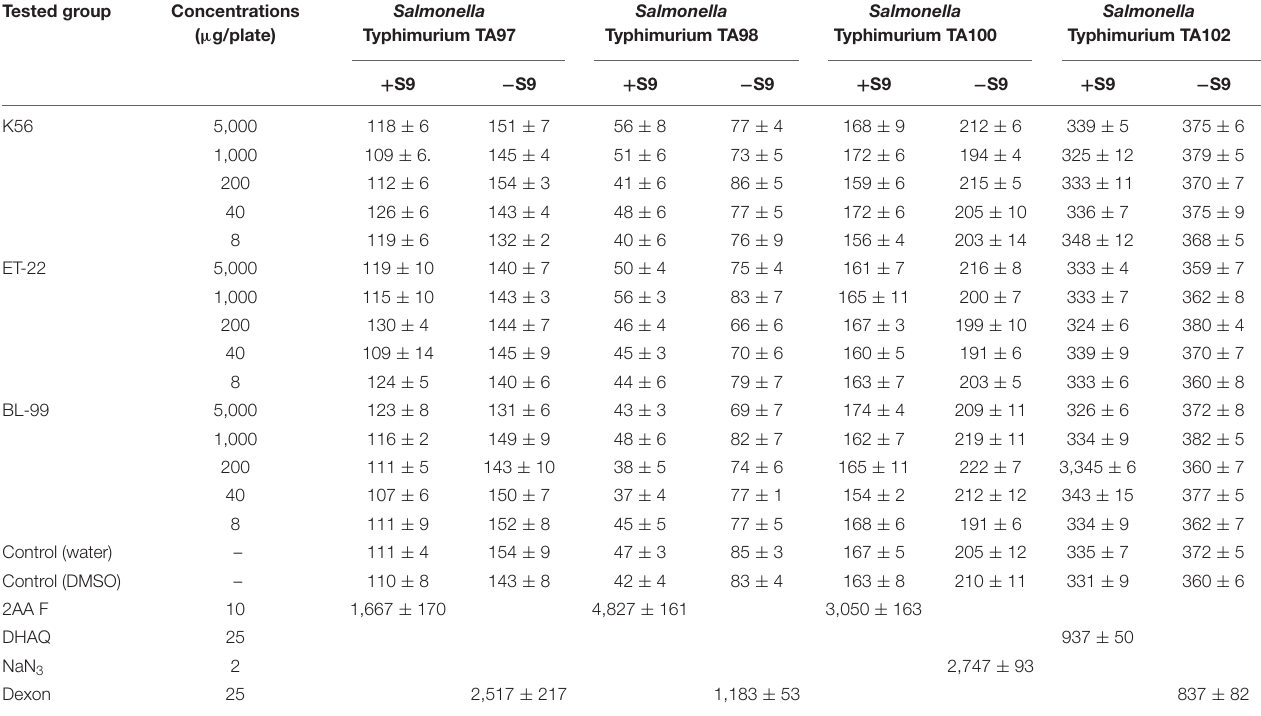
TABLE 1 | Bacterial reverse mutation test conducted with K56, ET-22, and BL-99. Tested group